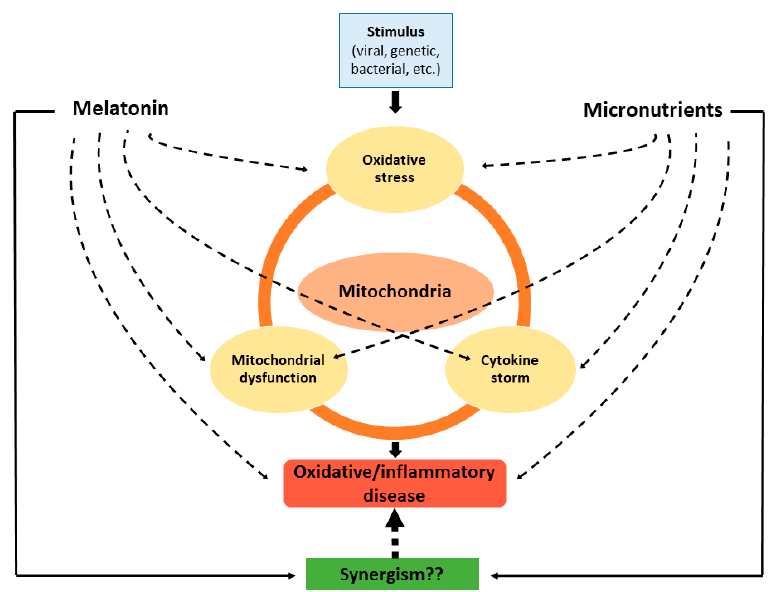
Figure 3. Effects of melatonin and micronutrients on mitochondria in the context of an oxida- tive/inflammatory disease. Dashed lines indicate “inhibition”.